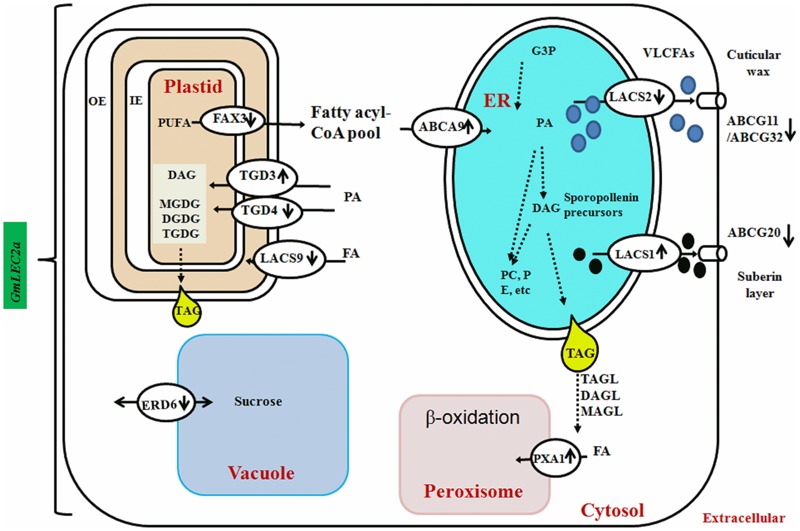
GmLEC2a control the lipid and sucrose transport in the soybean. FAs synthesized in chloroplasts need to be exported to the ER for the biosynthesis of TAG, polar lipids, wax and cuticle. Fatty acid export1 (FAX1) localized in the inner envelope (IE) exports FAs out of chloroplast lumen. TGDs transport complex and LACS9 present at chloroplast envelope membranes is involved in import of phospholipids and other glycolipid precursors into the chloroplast. The ABCA9 is responsible for FA import into ER for synthesis of TAG and phospholipids. The ER assembled precursors for cutin and wax biosynthesis are transported out by LACS1, LACS2. At the plasma membrane ABCG11, ABCG32 export wax and cutin precursors out of epidermal cells for deposition on plant tissue surfaces. The ABCG20 provide precursors for suberin layer formation. The PXA1 transport FA into peroxisome for β-oxidation. The AtERD6–like encode a sucrose transporter that is similar to sugar beet tonoplast membrane protein. The direction of vertical arrows beside the name of transporter indicated that specific transporter is either down or up-regulated by GmLEC2a.